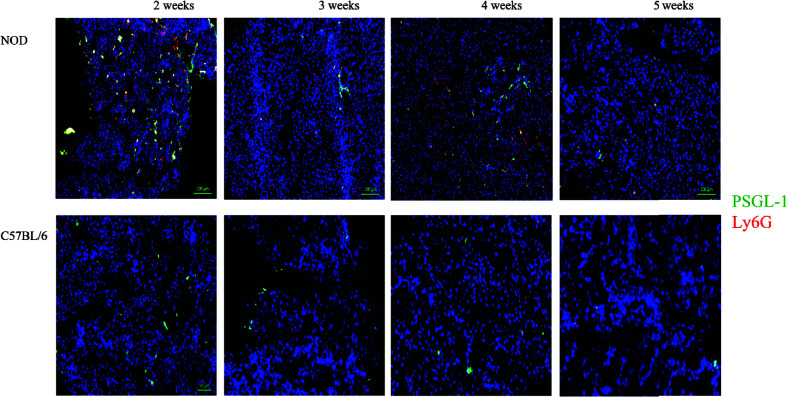
Generalized distribution PSGL-1 and Ly6G in the non-endocrine tissue of NOD, but not C57BL/6 pancreata at 2 weeks of age. Serial sections from formalin-fixed paraffin-embedded pancreata of 3-5 week old female NOD and C57BL/6 mice were stained with fluorochrome-tagged antibodies to PSGL-1 and Ly6G. Immunofluorescence shown is representative of outcomes observed in at least three individual mice of each strain. Bar at the bottom of each image represents the length of 100 μm.